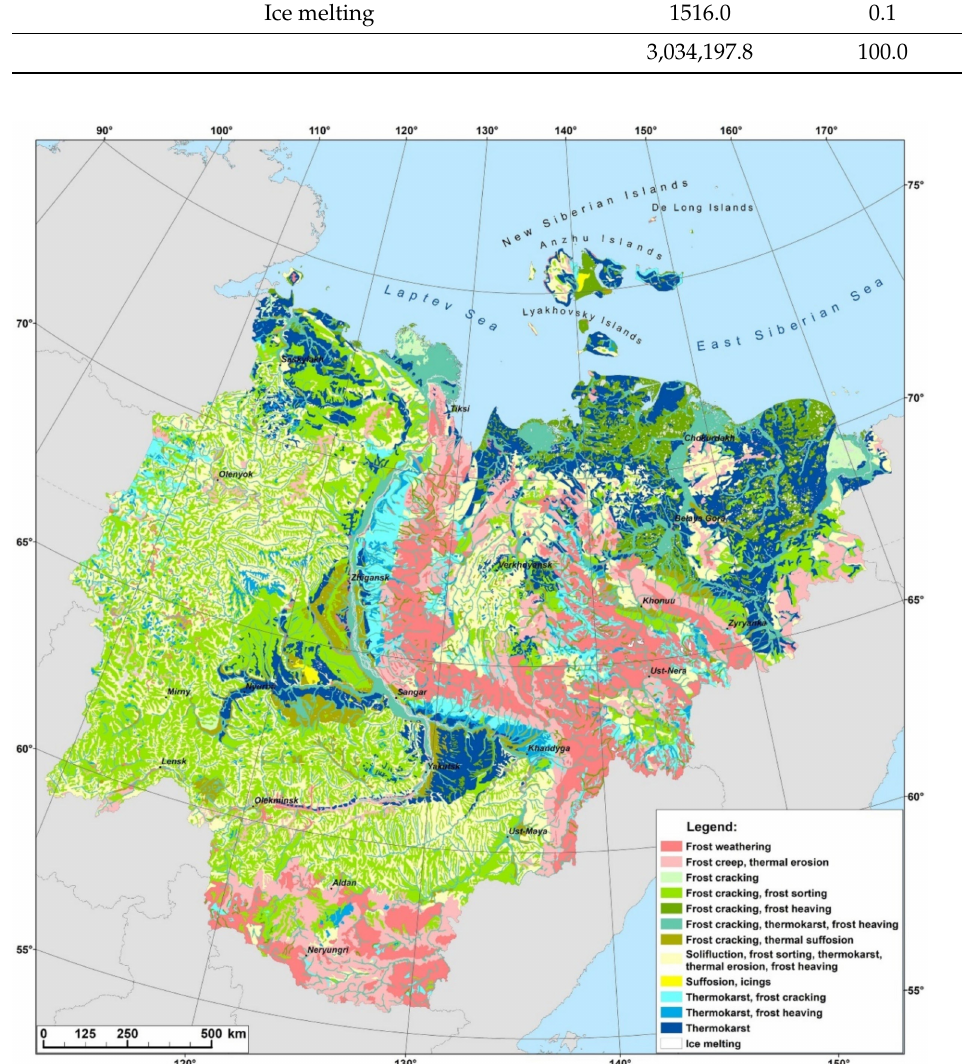
Figure 6. Map of the distribution of cryogenic